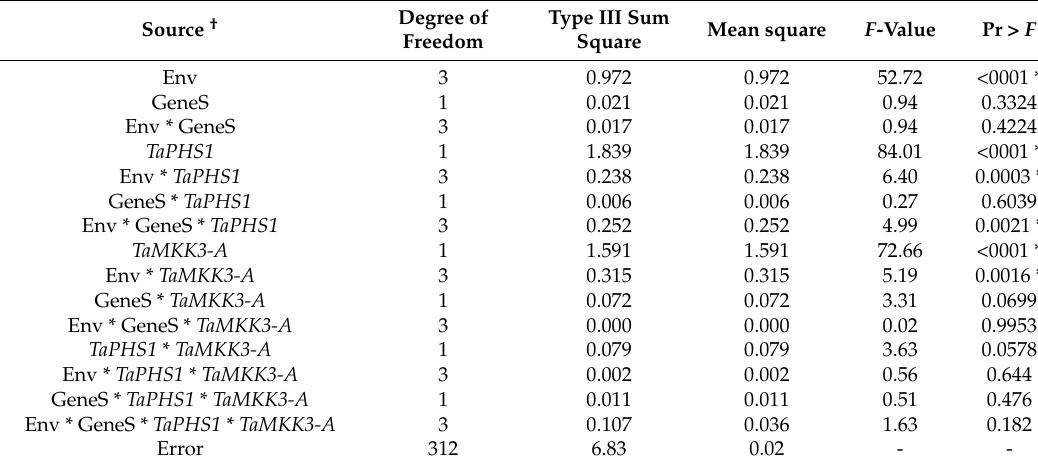
Table 2. Overall analysis of variance (ANOVA) of germination rates of the selected backcross progenies of NW97S186/Tutoumai A and NW97S186/AUS1408 in the 2015 fall and 2016 spring greenhouse experiments and in the 2016 Manhattan and Hays, KS, field